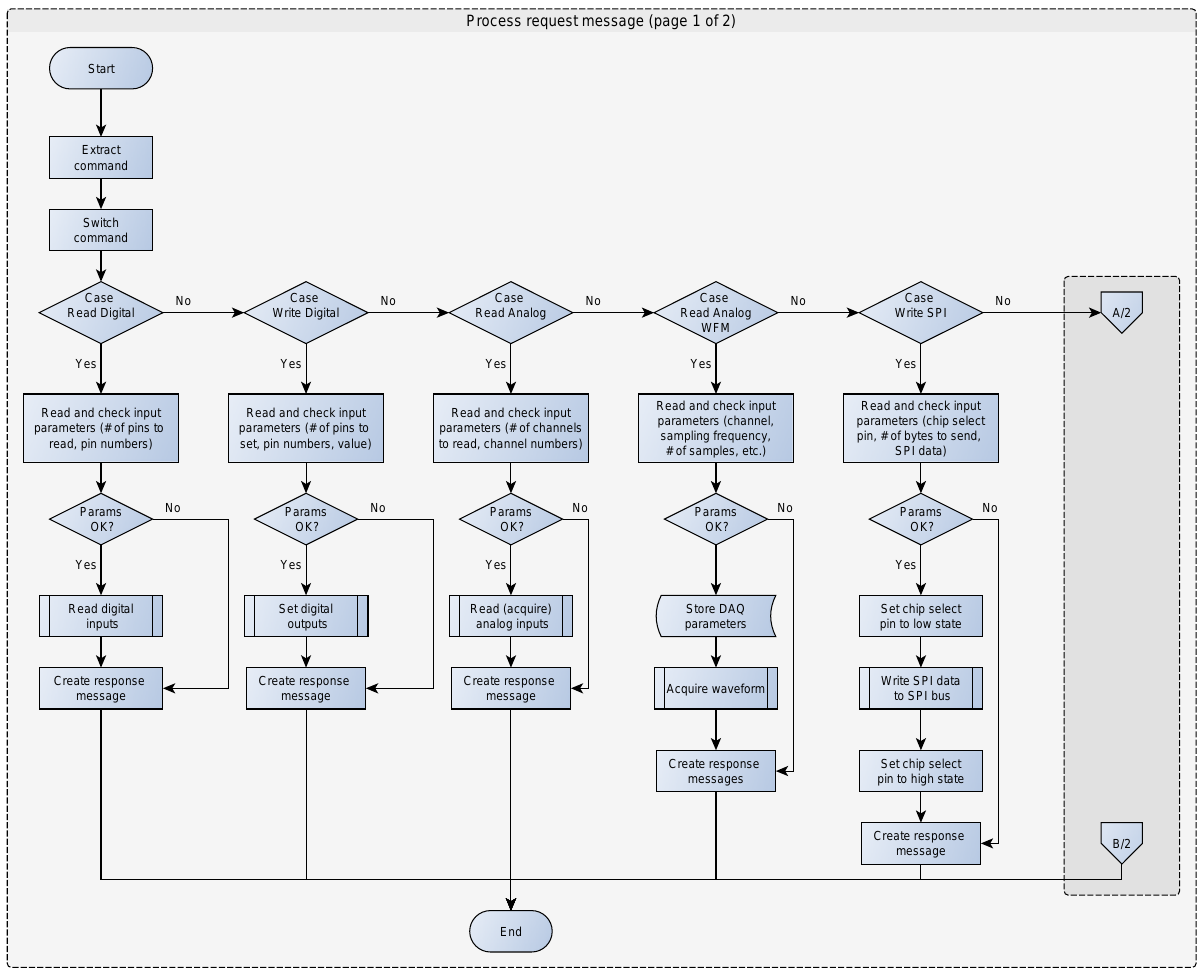
Figure 4 . SimpleDAQ firmware flowchart: processing request